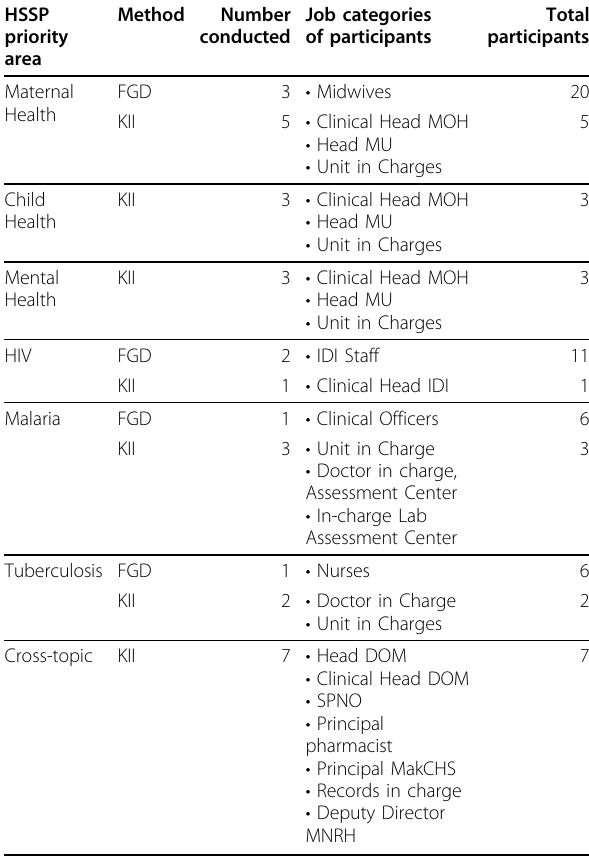
Table 1 Participant